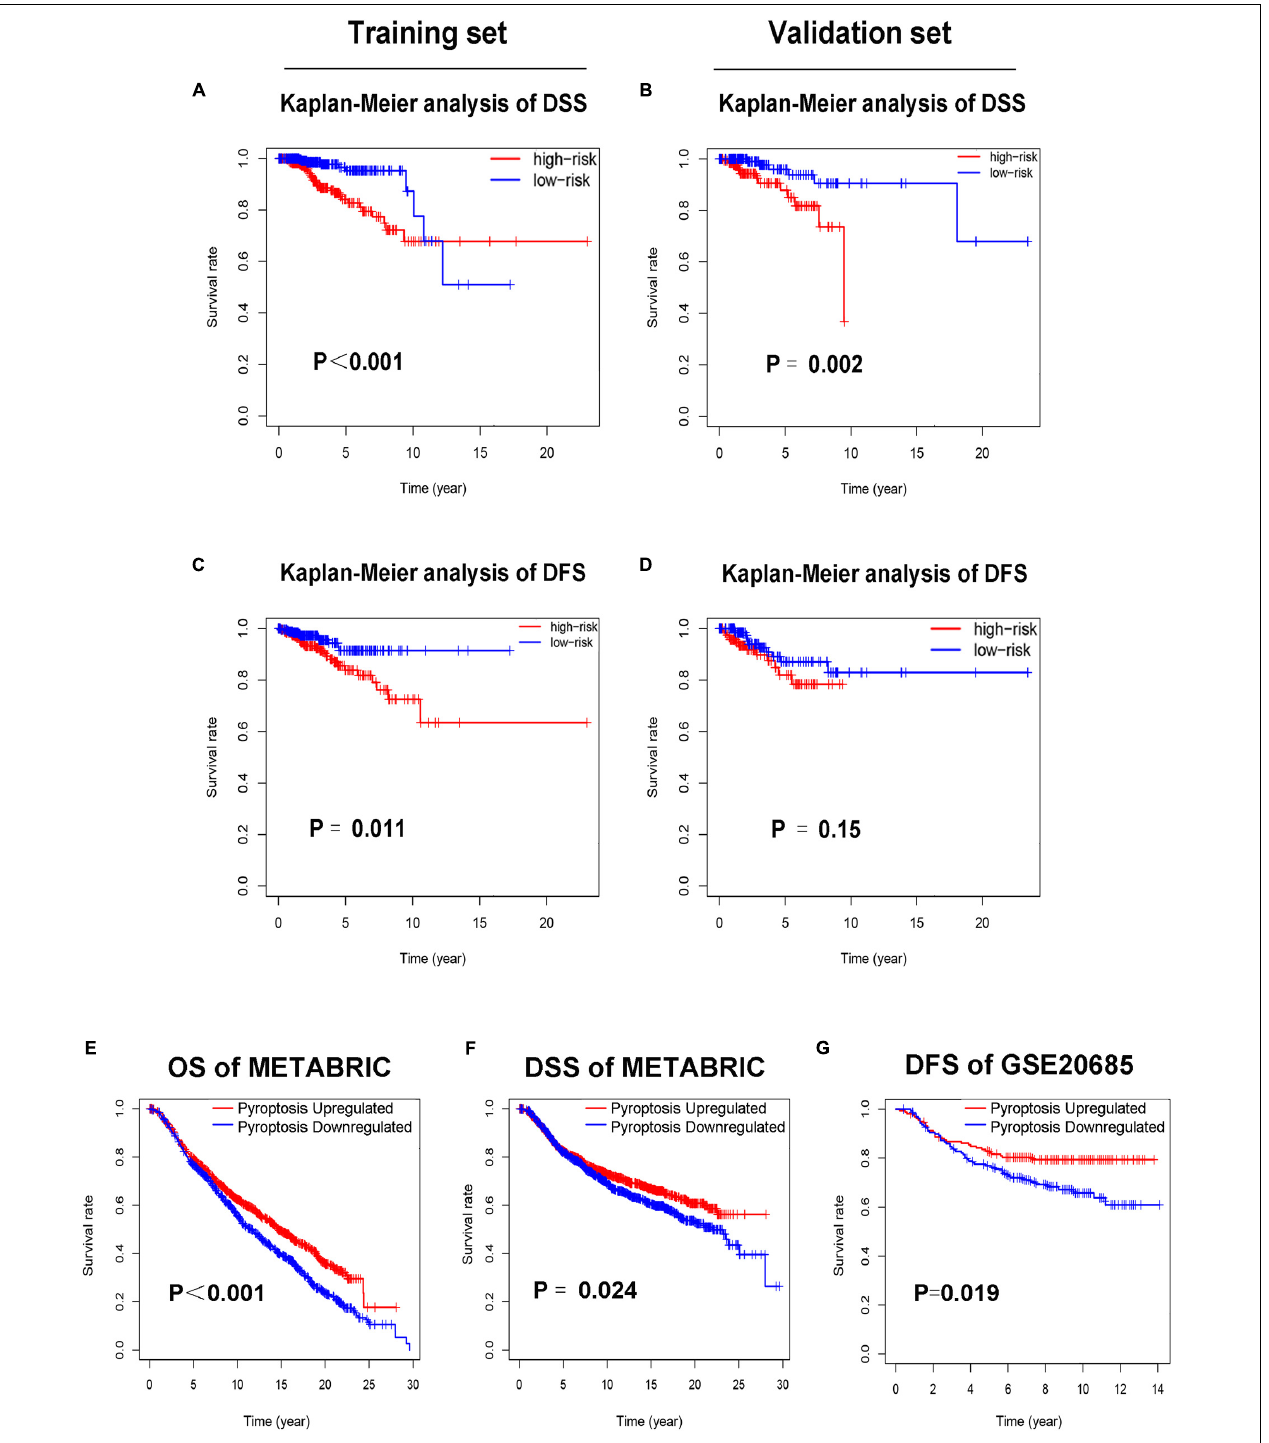
FIGURE 4 | Low-risk patients had better prognosis, and pyroptosis-upregulated group had better prognosis. (A) . Kaplan–Meier curves of DSS between the high-risk and low-risk groups in the training set. (B) Kaplan–Meier curves of DSS between the high-risk and low-risk groups in the validation set. (C) Kaplan–Meier curves of DFS between the high-risk and low-risk groups in the training set. (D) Kaplan–Meier curves of DFS between the high-risk and low-risk groups in the validation set. (E) Kaplan–Meier curves of OS between the pyroptosis-upregulated and pyroptosis-downregulated groups in the METABRIC database. (F) Kaplan–Meier curves of DSS between the pyroptosis-upregulated and pyroptosis-downregulated groups in the METABRIC database. (G) Kaplan–Meier curves of DFS between the pyroptosis-upregulated and pyroptosis-downregulated groups in the GSE20685 database.